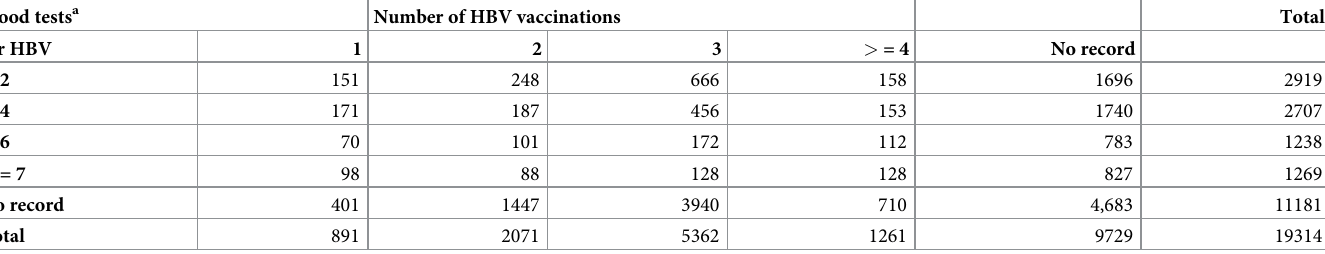
Table 3. Number of HBV blood tests peformed and HBV vaccinations received (per individual), Top End, Northern Territory, 2016 shown on data linked